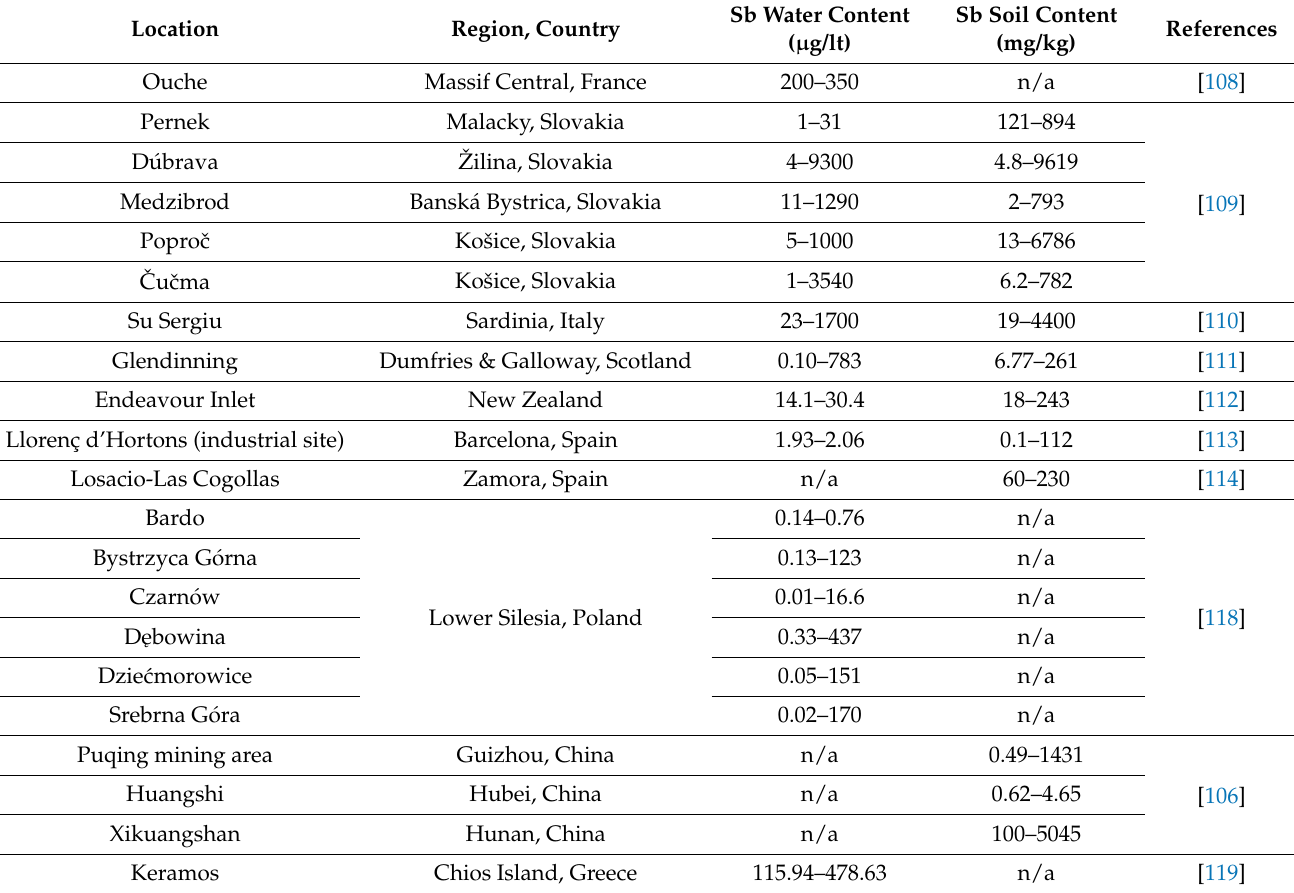
Table 3. Soil and water Sb pollution in selected Sb mining